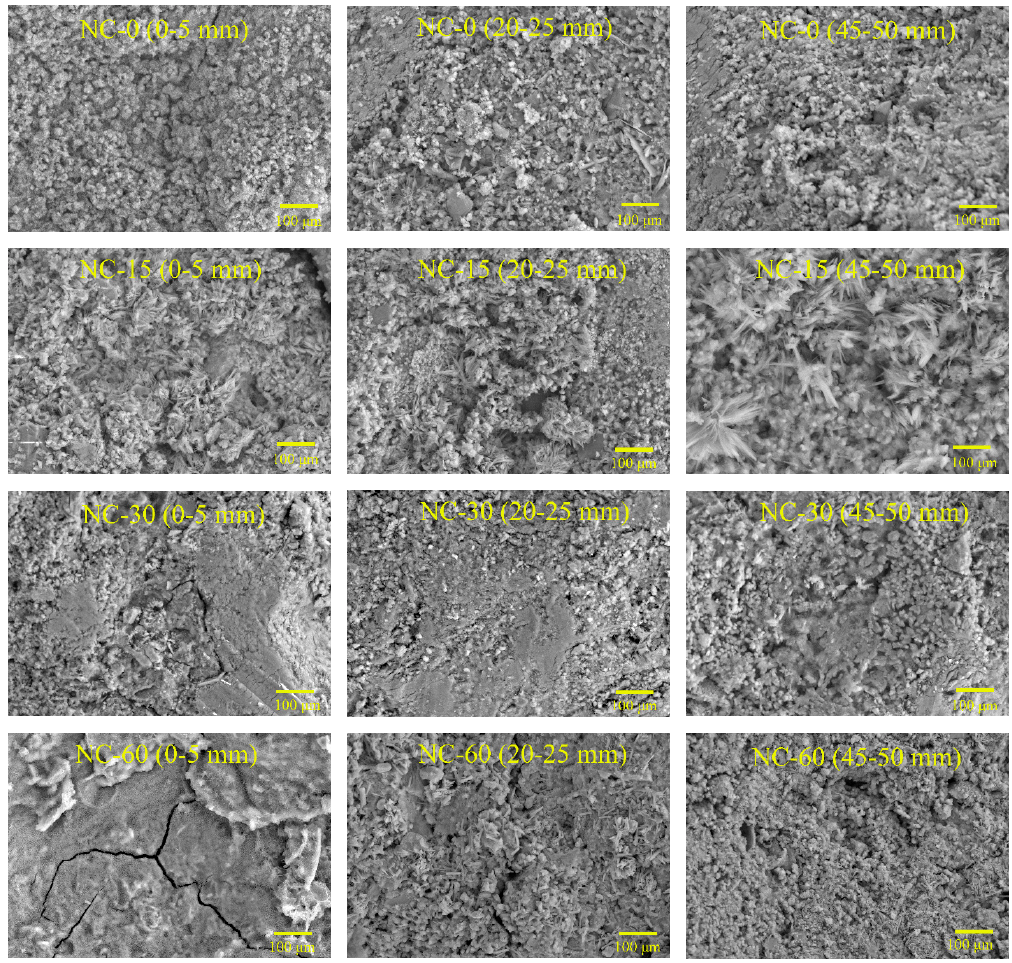
Figure 9. Scanning electron microscopy (SEM) images of NC concretes, after 0, 15, 30, and 60 cycles of sulfate attack (sample location from attack surface: 0–5 mm, 20–25 mm, and 45–50 mm).